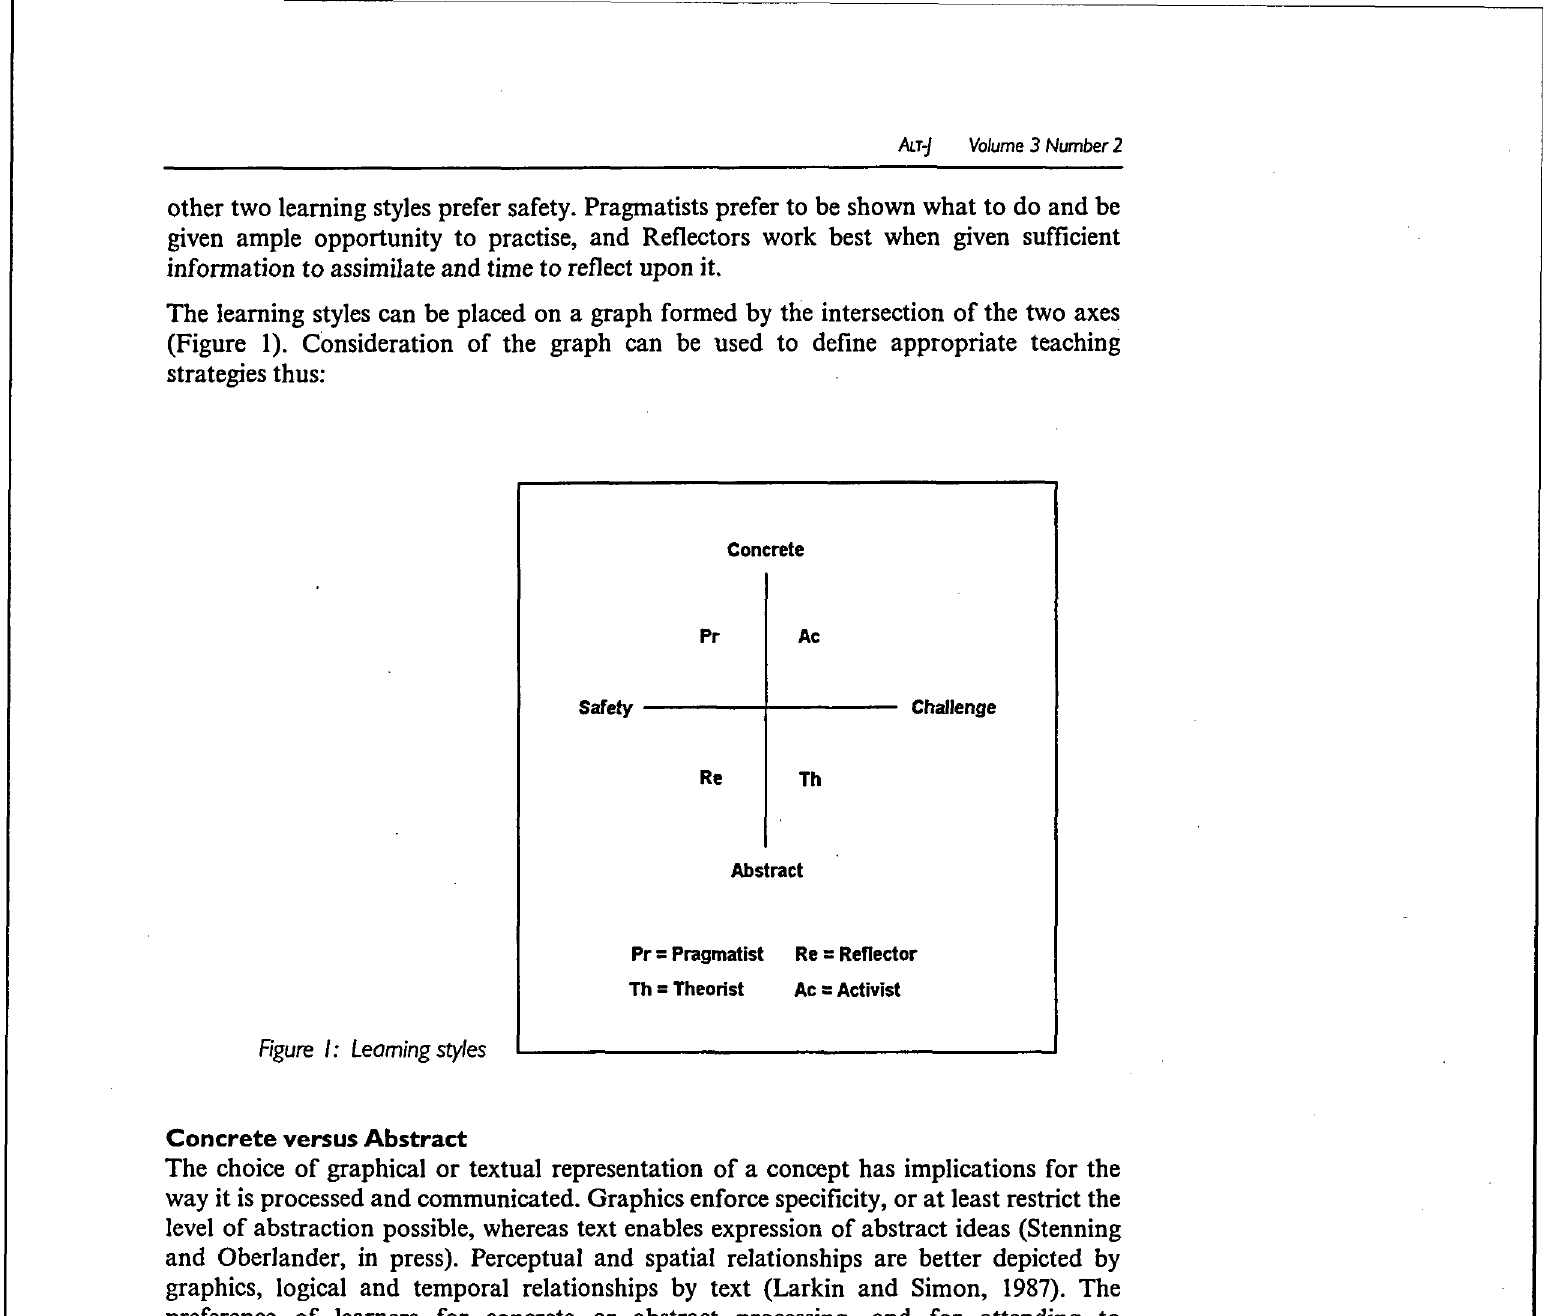
Figure I: Learning